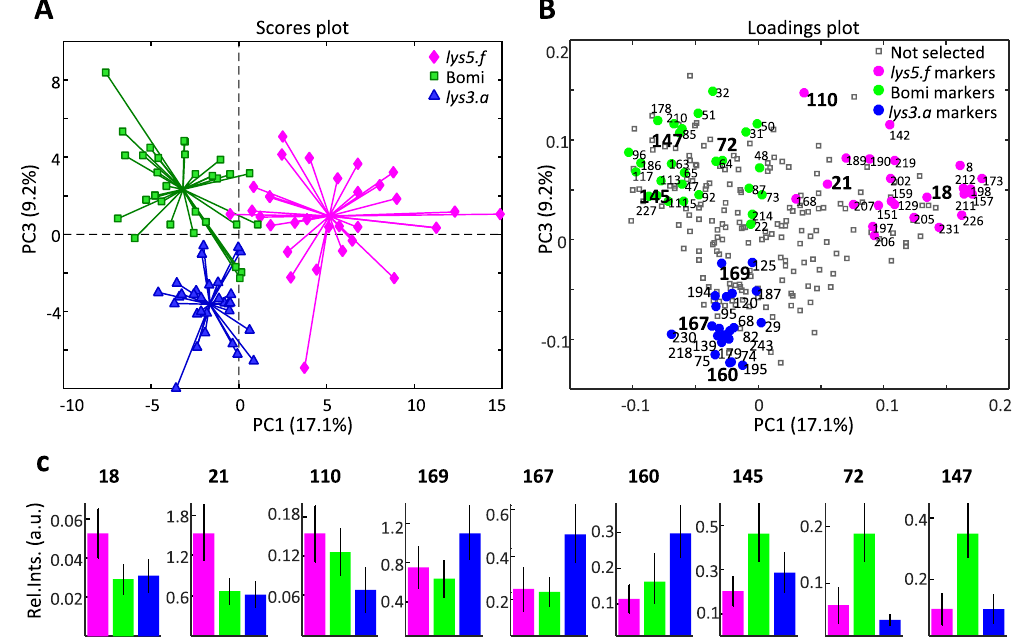
Figure 2. Principal component analysis (PCA) of the ANOVA-simultaneous component analysis (ASCA)- based genotype effect separated matrix, X GT . ( A ) Scores plot of the PCA model developed on X GT . ( B ) The loadings plot of the corresponding PCA model highlights the most discriminative metabolite markers for each genotype, selected by the corresponding PLS-DA models using a variable selection approach. ( C ) Relative mean concentrations of some metabolite markers, calculated from the raw data, for lys5.f (18: maltol, 21: 3-methyl-2-furoate, 110: α -methyl-4-hydroxymandelic acid, methyl ester), Bomi (169: sinapinic acid, methyl ester, 167: isoferulic acid, 160: 2-hydroxysebacic acid) and lys3.a (145: gallic acid, 72: 2-ketoglutaric acid, 147: 4-hydroxymandelic acid, ethyl